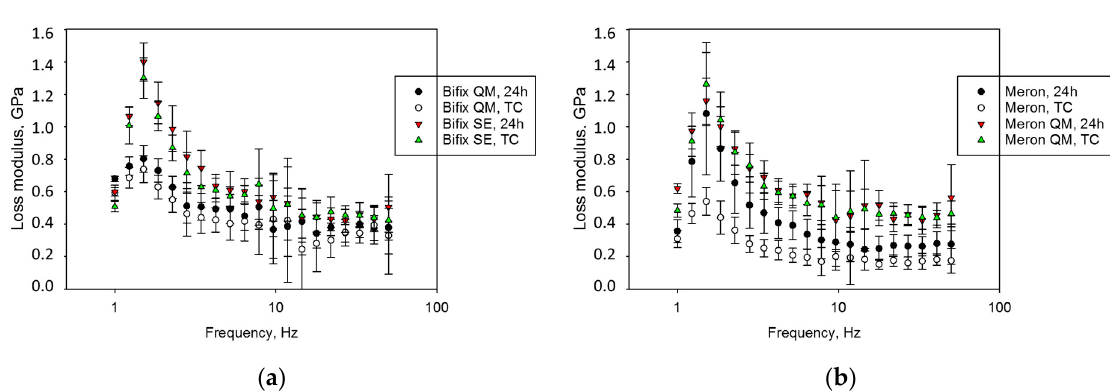
Figure 5. Variation of the loss modulus (E ″ ) over the frequency range 1–50 Hz for ( a ) Bifix QM and Bifix SE; ( b ) Meron and Meron QM.